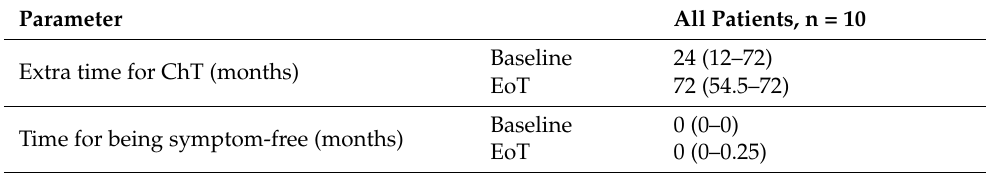
Table 3. Results Time Trade-off (TTO). Given are median (SD), EoT, end of treatment ChT, chemotherapy. Parameter All Patients, n = 10 Extra time for ChT (months) Time for being symptom-free